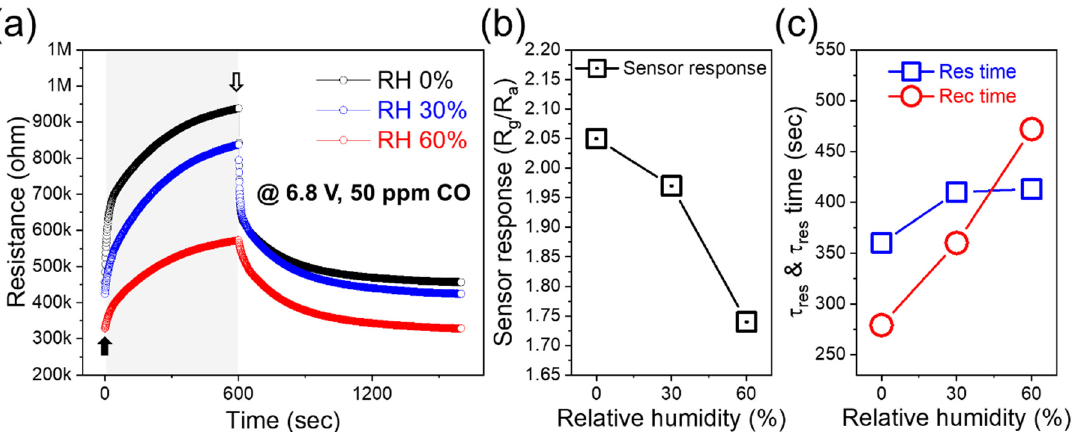
Figure 8. ( a ) Dynamic resistance curves of Au-decorated 10 wt% SnO 2 –WS 2 gas sensor to 50 ppm CO gas under 6.8 V external voltage at different RH. Corresponding ( b ) sensor response, ( c ) response and recovery times as a function of RH.